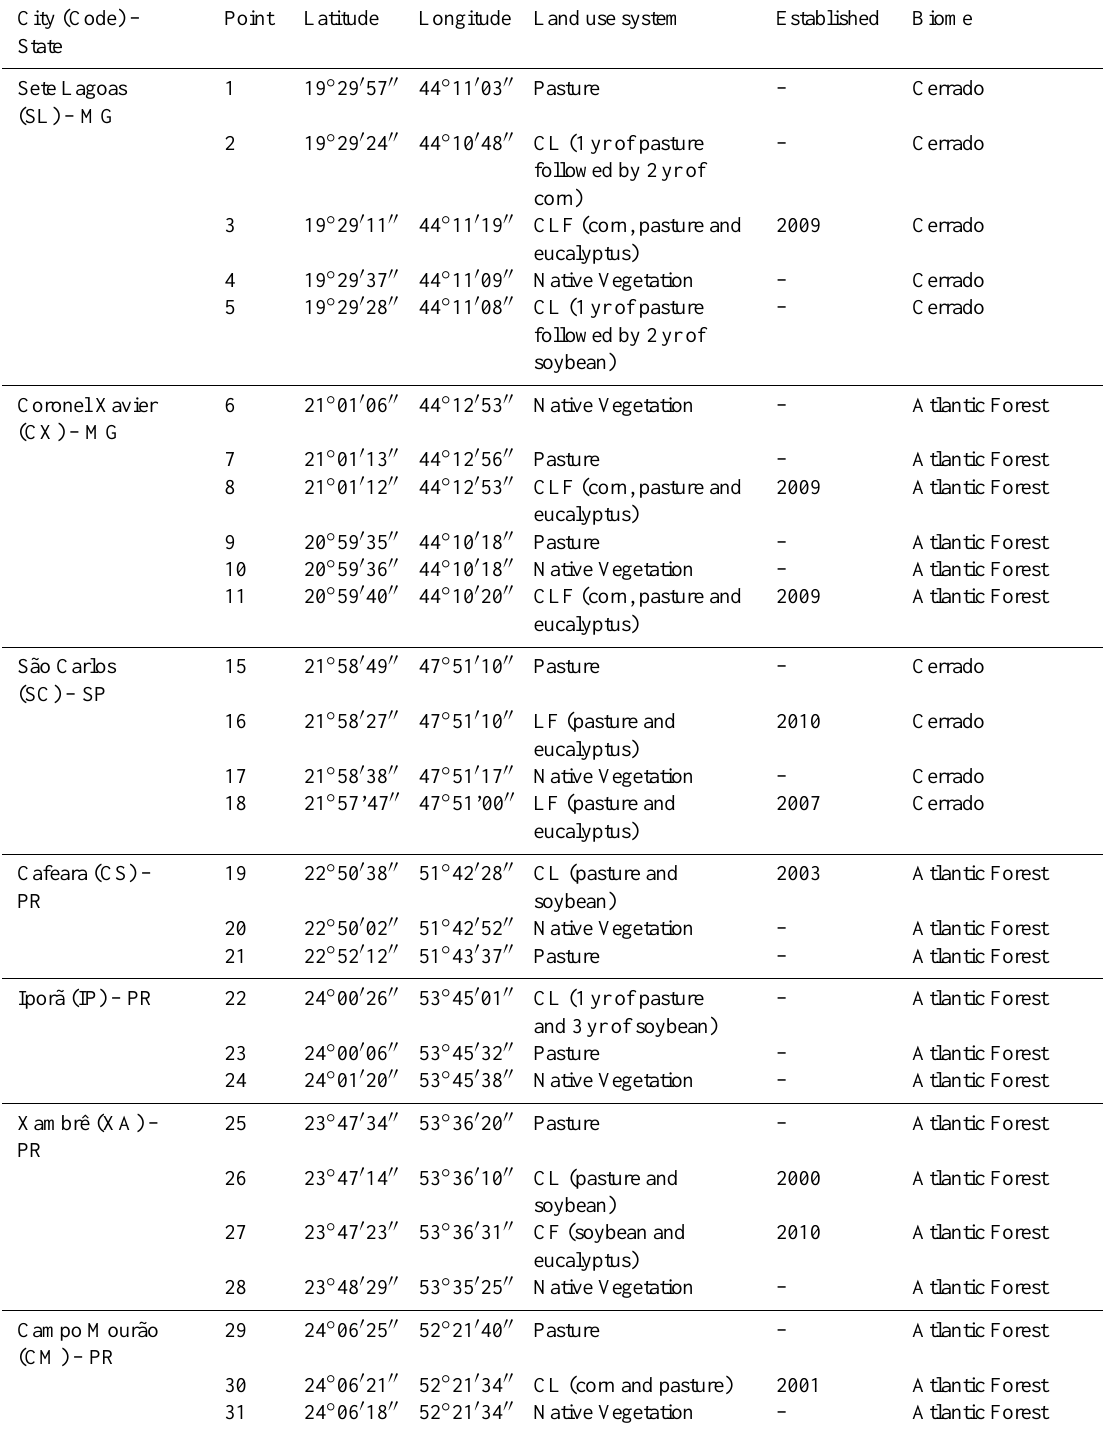
Table 1. Characterization of sampled sites: native vegetation (NV), pastures (P), crop-livestock systems (CL), livestock-forest systems (LF), crop-forest systems (CF) and crop-livestock-forest systems